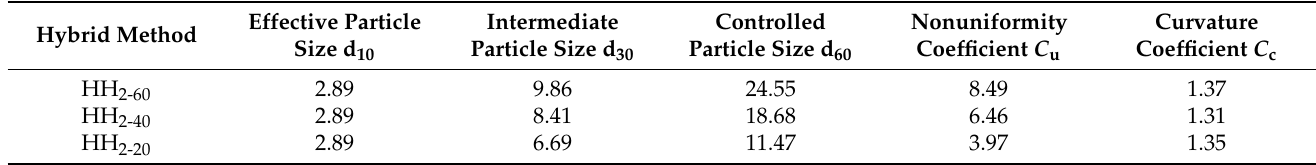
Table 1. The test gradation of rockfill materials and tested results.